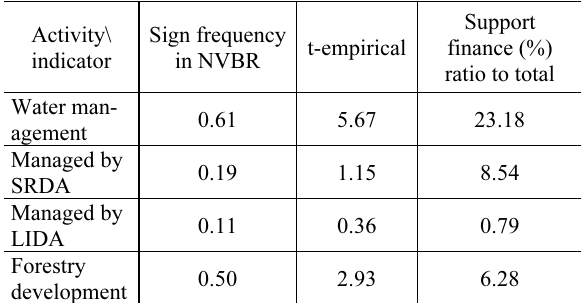
Table 13 . Results of different EU structural fund distribution